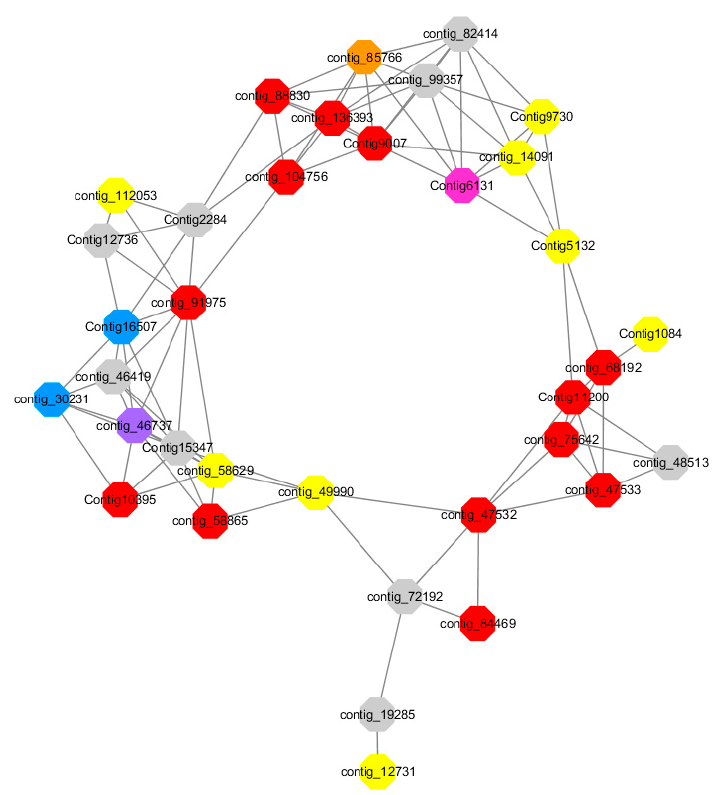
Figure 14. GCN of Module 1.